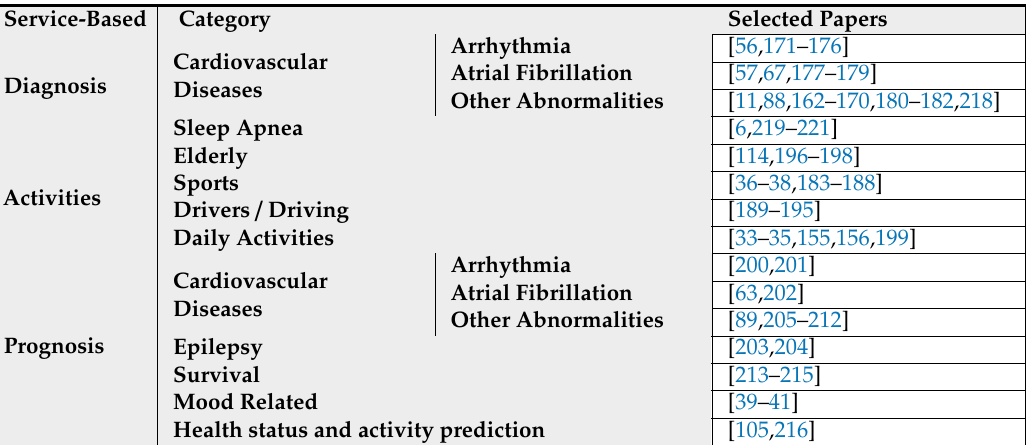
Table 5. Classification of selected service-based ECG monitoring